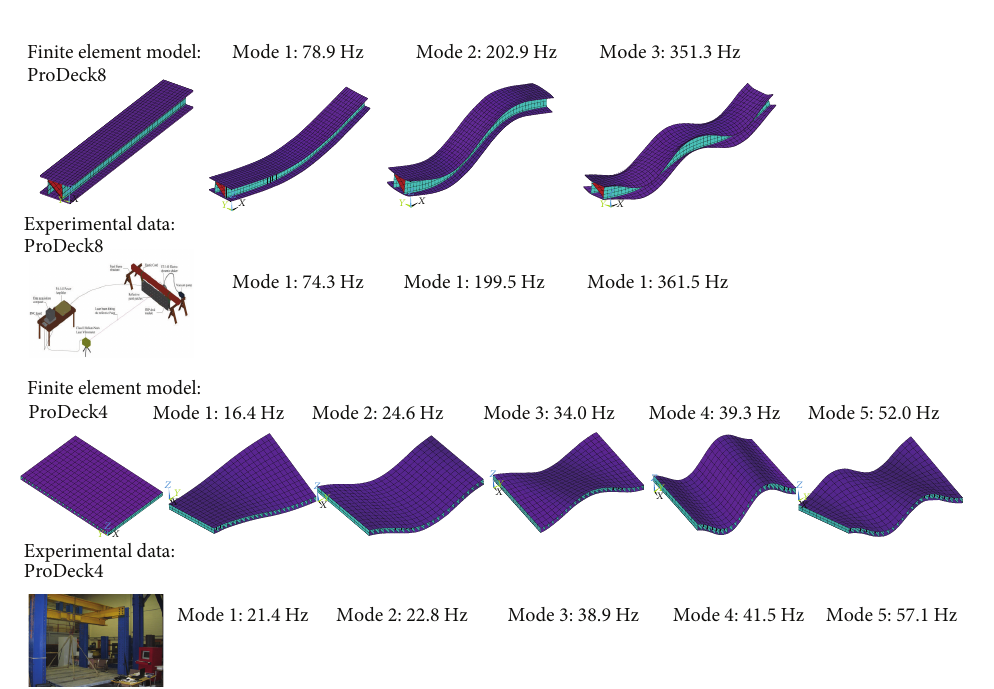
Figure 6: Simulation of moving truck using the load-step method.